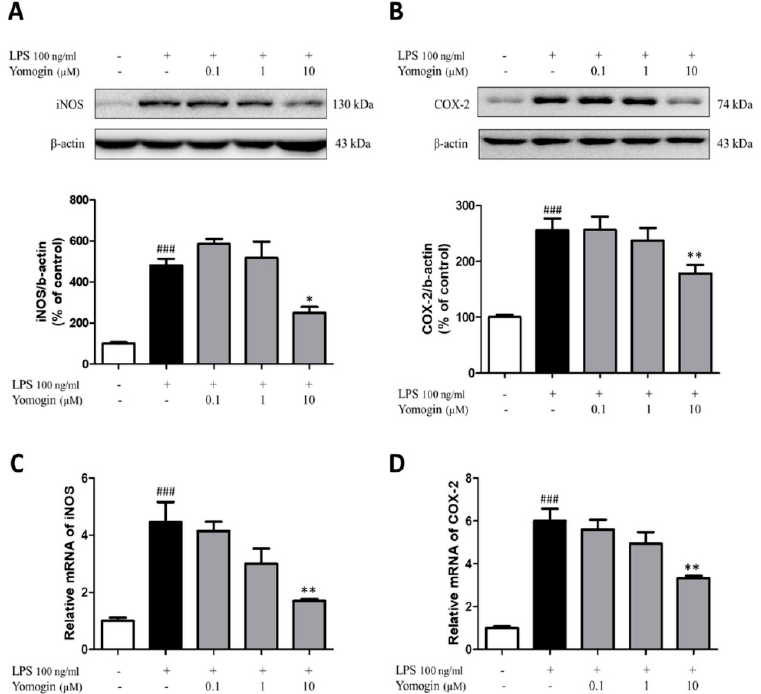
Figure 4. Effects of yomogin on expressions of iNOS and COX-2 in LPS-stimulated BV2 microglial cells. The cells were treated with various concentrations (0.1–10 µ M) of yomogin for 1 h before LPS treatment. The protein levels of iNOS ( A ) and COX-2 ( B ) were determined by Western blotting ( n = 5–6 per group). The mRNA levels of iNOS ( C ) and COX-2 ( D ) were analyzed by qRT-PCR ( n = 6 per group). Data were analyzed by one-way ANOVA, followed by Tukey’s post hoc test. ### p < 0.001 compared to the control group; * p < 0.05 and ** p < 0.01 compared to the LPS-only-treated group. Values are the mean ± SEM.